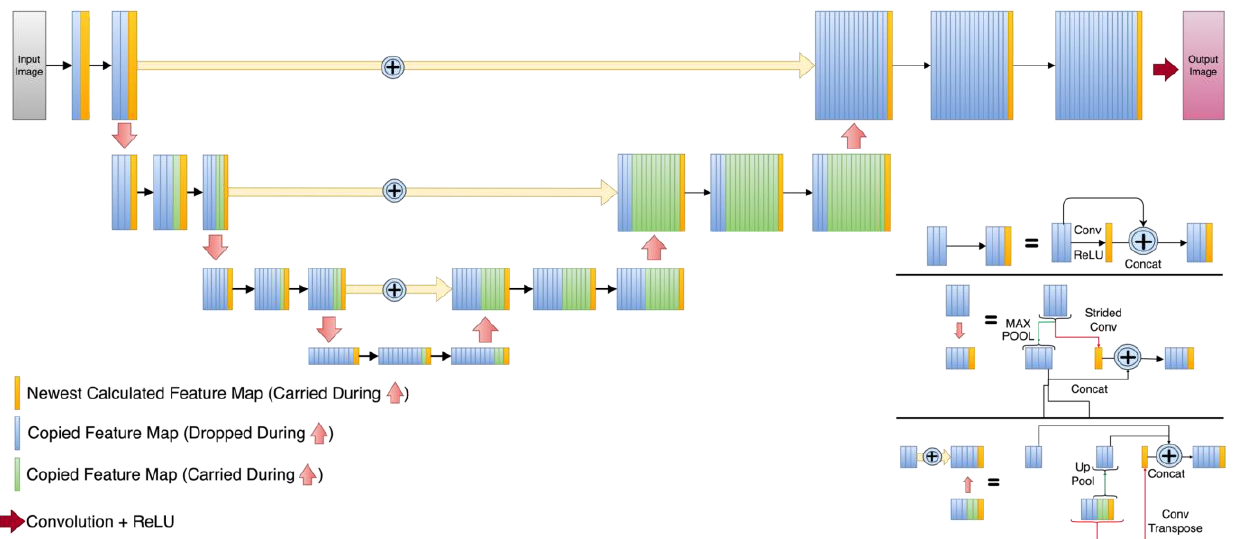
Figure 2. Dense UNet (DUNet) architecture. Orange rectangles represent the newly calculated feature maps at every level. Blue rectangles are the feature maps that are dropped during the expansion path and green rectangles are the feature maps that are copied during the expansion path.